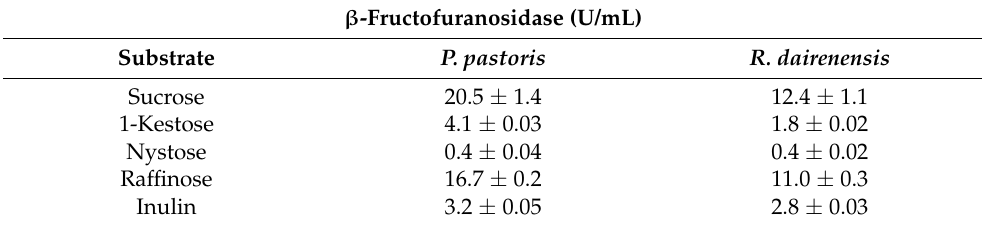
Table 1. Substrate specificity of RdINV expressed in the indicated yeast.